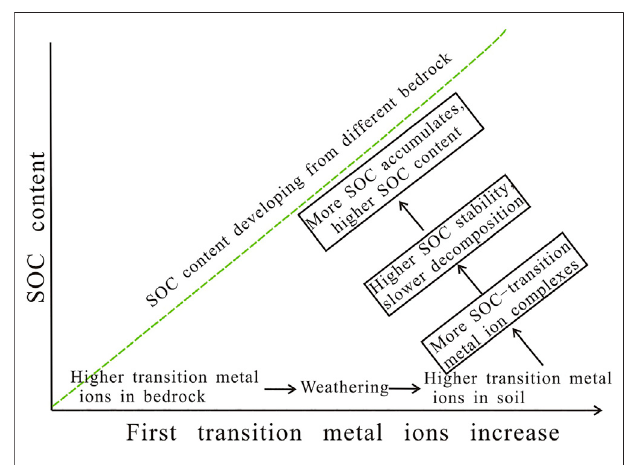
FIGURE 8 | SOC evolution model in fl uenced by the